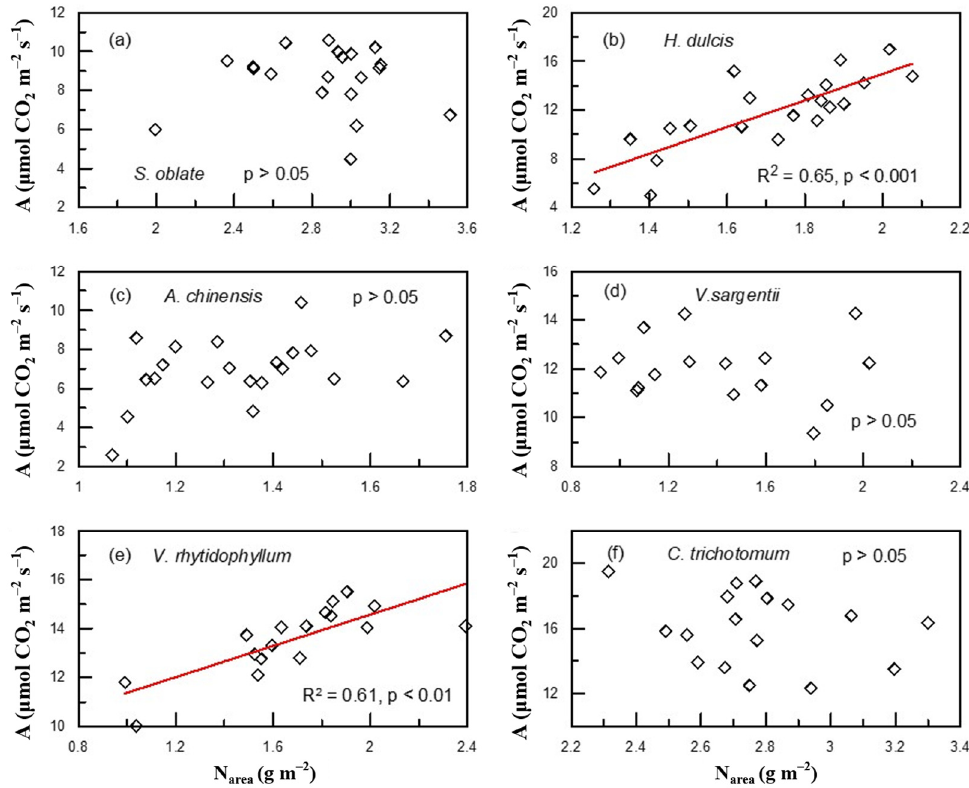
Figure 4. Relationships between leaf N based on area (N area ) and photosynthetic rate (A) on plant individual level for plants derived from the third sampling campaign: ( a ) S. oblate , ( b ) H. dulcis , ( c ) A. chinensis , ( d ) V.sargentii , ( e ) V. rhytidophyllum , ( f ) C. trichotomum .